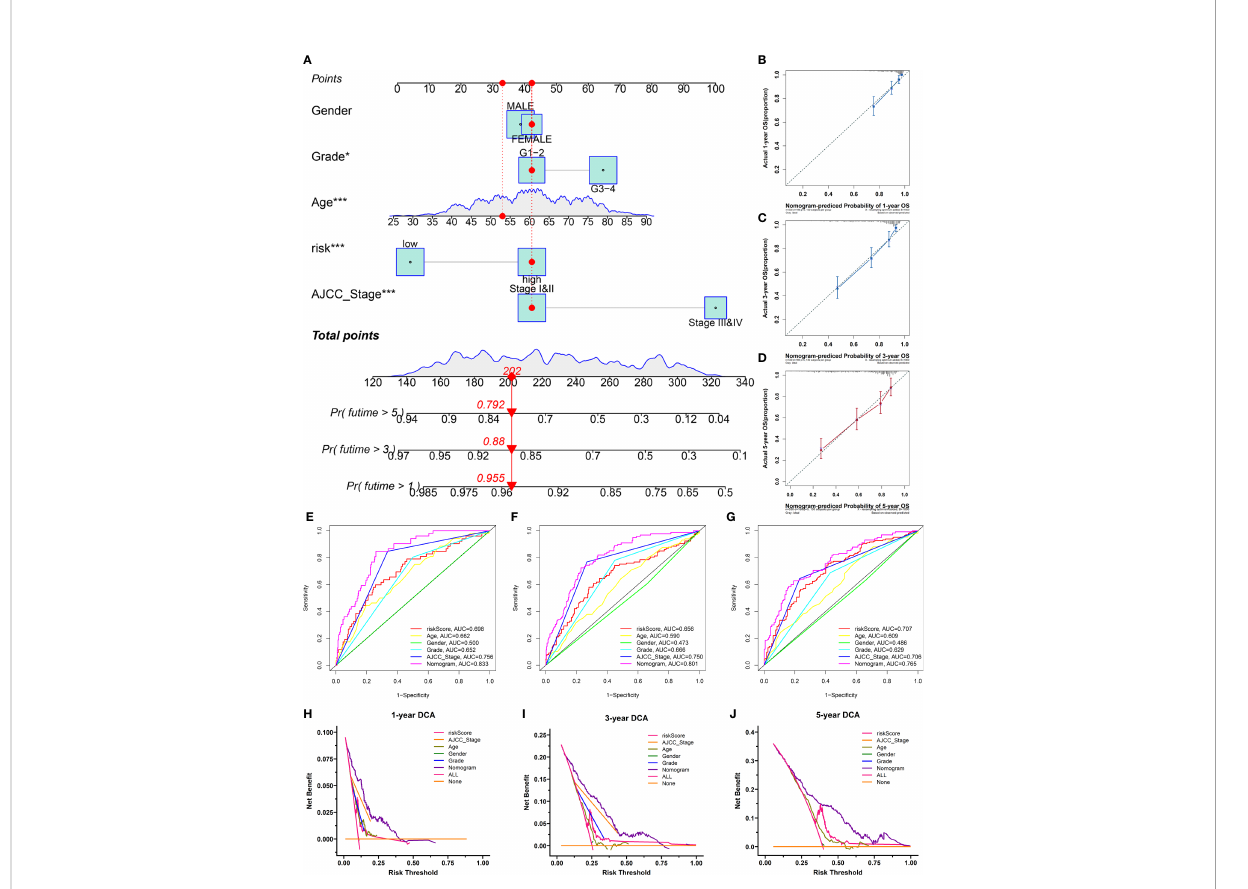
FIGURE 10 The nomogram was developed for prognostic probabilities prediction in the TCGA database. (A) Development of a nomogram for predicting survival probability of KIRC patients at 1-, 3-, and 5-years. (B – D) The calibration curves of the nomogram at 1-, 3-, and 5-years. (E – G) The time ‐ dependent ROC curves of the nomogram at 1-, 3-, and 5-years. (H – J) The DCA curves of the nomogram at 1-, 3-, and 5-years. *p<0.05;